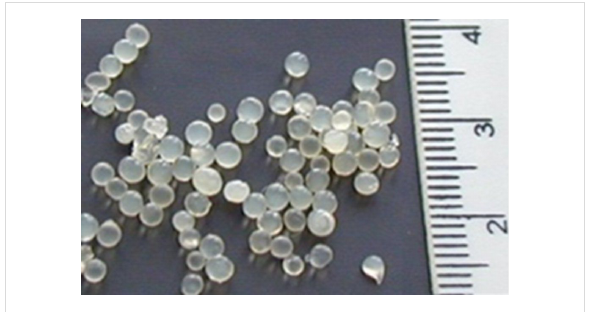
Figure 12: Beads produced from Ca-alginate and TEOS containing co-encapsulated F ate DH, F ald DH and ADH.